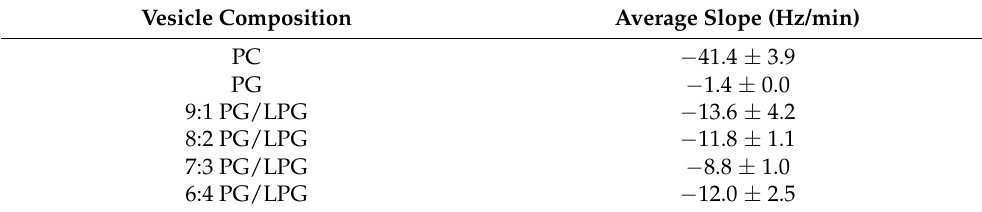
Table 3. Average slope of frequency shift resulting from vesicle adsorption to the silica surface